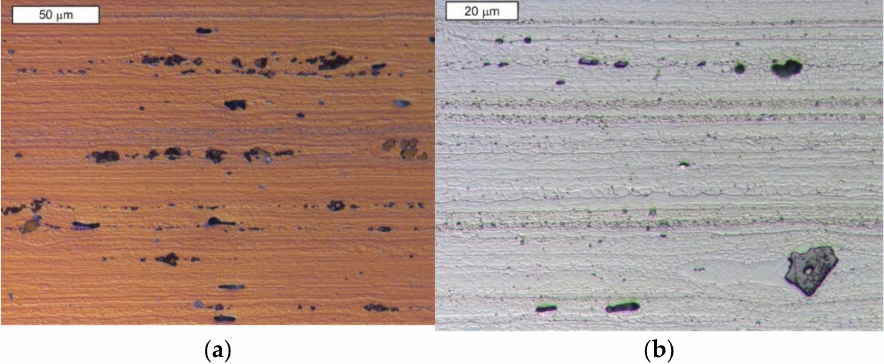
Figure 8. Magnified image of the alloy microstructure in the DA state: ( a ) DIC contrast and ( b ) bright- field (BF). Etched state, light